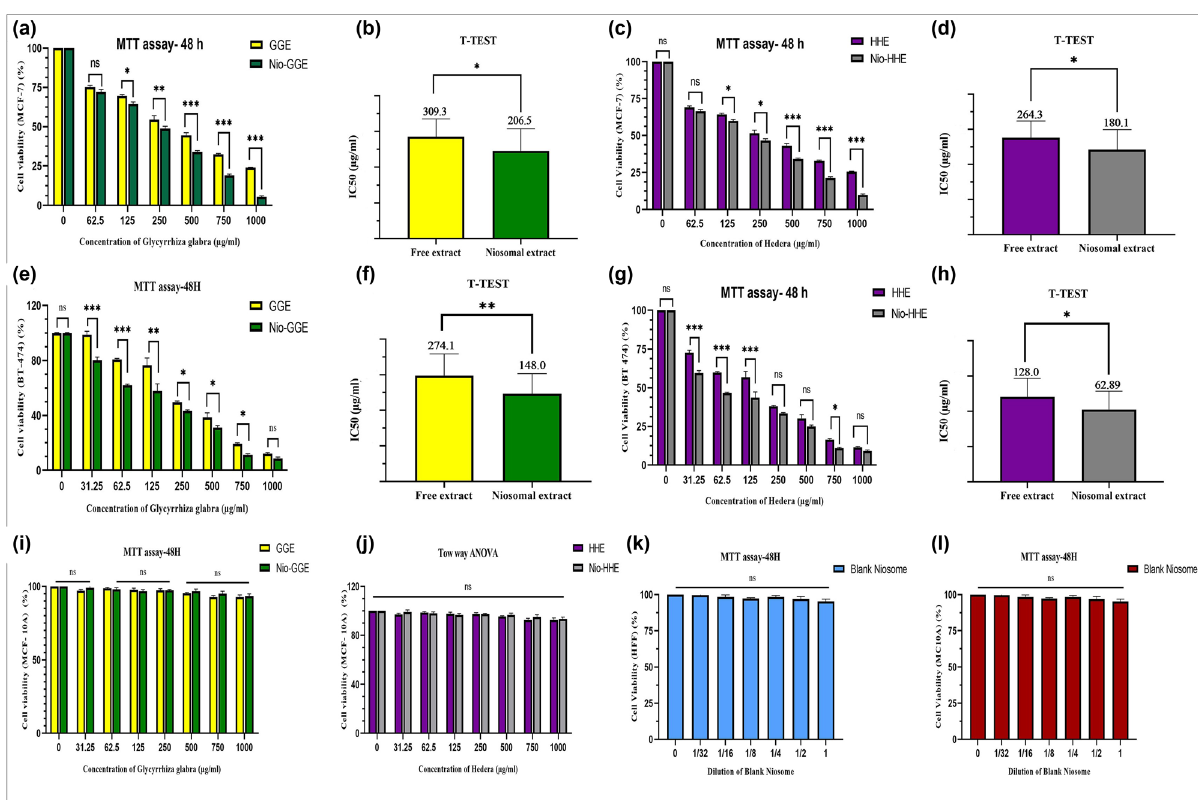
Figure 9: Cytotoxicity studies: ( a ) the cell viability rate ( % ) of MCF - 7 cells after treatment with various concentrations of GGE and Nio - GGE in 48 h. ( b ) Comparative study of IC 50 GGE and Nio - GGE on MCF - 7 cancer cells. ( c ) The cell viability rate ( % ) of MCF - 7 cells after treatment with various concentrations of HHE and Nio - HHE in 48 h. ( d ) Comparative study of IC 50 HHE and Nio - HHE on MCF - 7 cancer cells. ( e ) The cell viability rate ( % ) of BT - 474 cells after treatment with various concentrations of GGE and Nio - GGE in 48 h. ( f ) Comparative study of IC 50 GGE and Nio - GGE on BT - 474 cancer cells. ( g ) The cell viability rate ( % ) of BT - 474 cells after treatment with various concentration of HHE and Nio - HHE in 48 h. ( h ) Comparative study of IC 50 HHE and Nio - HHE on BT - 474 cancer cells. ( i ) The cell viability rate ( % ) of MCF 10A cells after treatment with various concentrations of GGE and Nio - GGE in 48 h. ( j ) The cell viability rate ( % ) of MCF 10A cells after treatment with various concentrations of HHE and Nio - HHE in 48 h. ( k ) The cell viability rate ( % ) of HFF cells after treatment with various diluent of blank niosome in 48 h. ( l ) The cell viability rate ( % ) of MCF 10A cells after treatment with various diluent of blank niosome in 48 h. ns: no signi fi cant di ff erence. *, **, **: P - value <